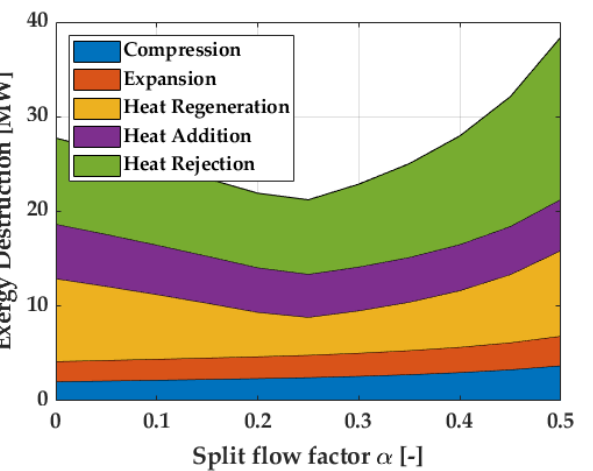
Figure 4. Changes in the profile of exergy destruction for a 50 MW th system for variable split- flow